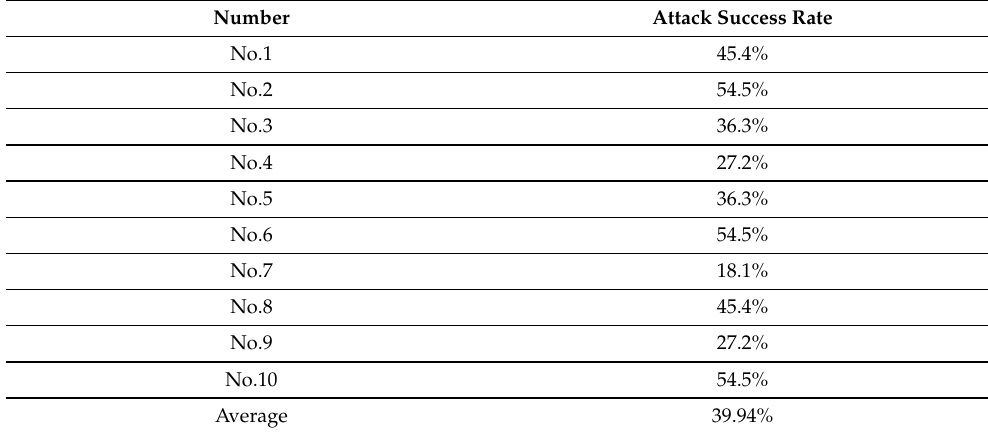
Figure 10. Generated adversarial masks. Table 9. Physical dodging attacks against 10-person face recognition